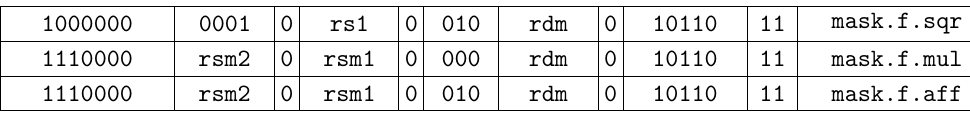
Table 9: Instruction encodings (F-class: operations for field